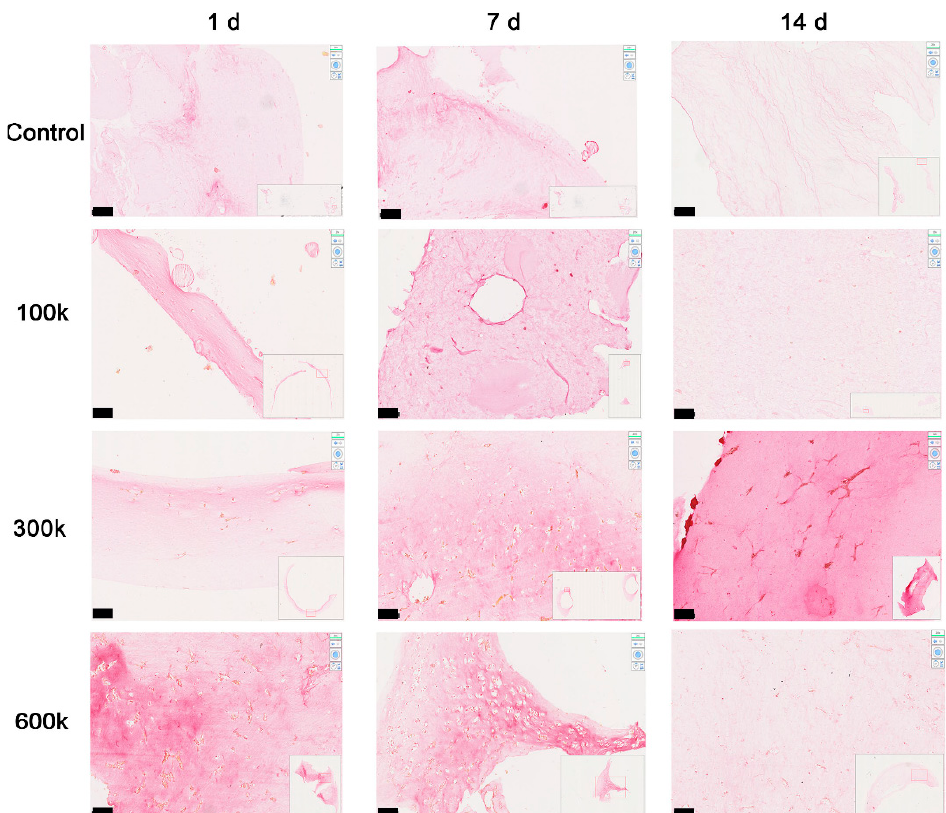
Figure 6. Influence on collagen organization of the VNF of HPMEC seeded in LV ECM hydrogels as examined by picrosirius red staining. Picrosirius red-stained sections of 100k, 300k, and 600k HPMEC in LV ECM hydrogel at 1 d, 7 d, and 14 d. As a control, bare LV ECM hydrogels were used. Staining intensity was markedly increased in the vicinity of cell clusters and tube-like structures in a seeding density-dependent fashion, while more distal of cells staining was weaker. The original magnification used for scan slides (insets) in Hamamatsu imaging was 20×. Scale bars represent 100 µm.